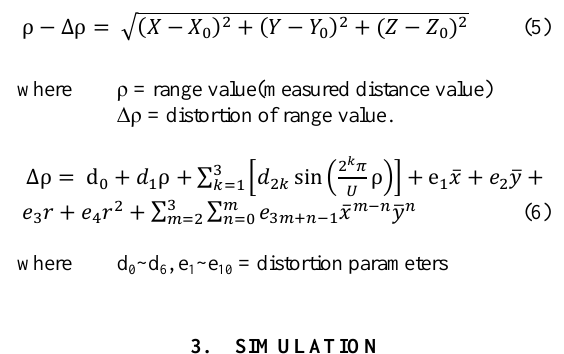
Figure 4. Flow chart of system calibration simulation